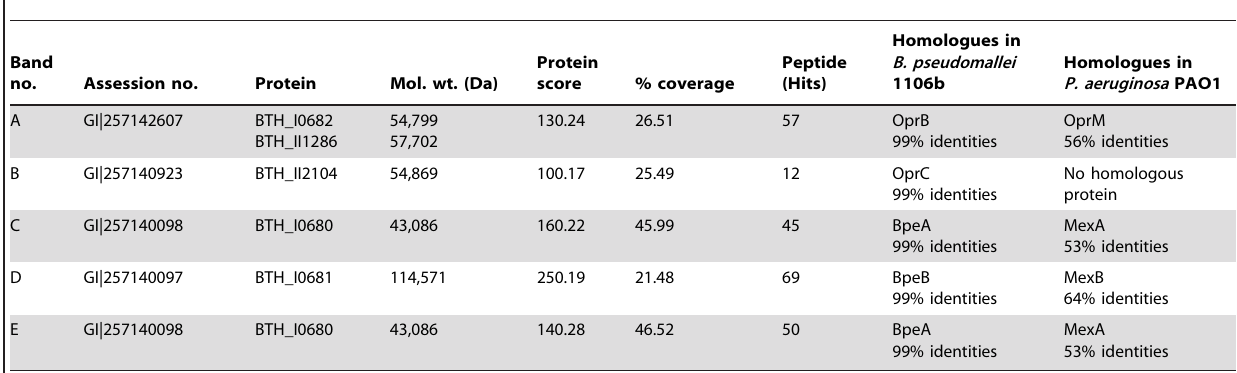
Table 3. Identification of two drug efflux pumps overproduced in the resistant variants.